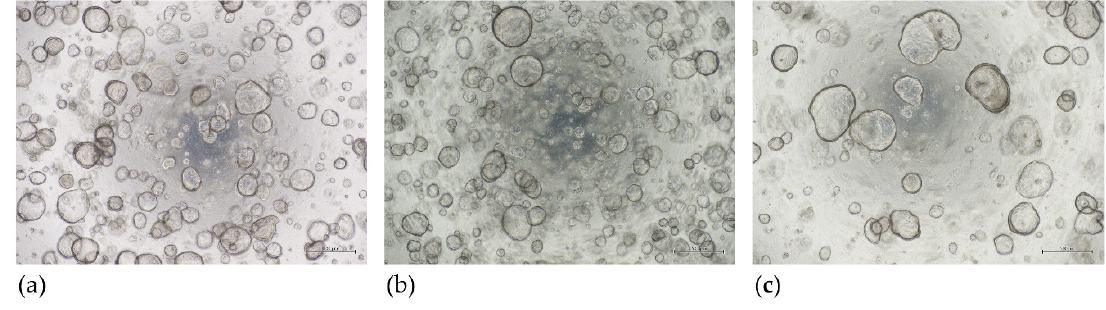
Figure 1. Novel endometrial organoids, passage 3; day 7. Menstrual fluid organoids (MFO) ( a ) and endometrial organoids derived from women taking hormonal medication (EMO-H) ( b ) can be generated and can recapitulate standard EMO ( c ). Bar 500 µm.